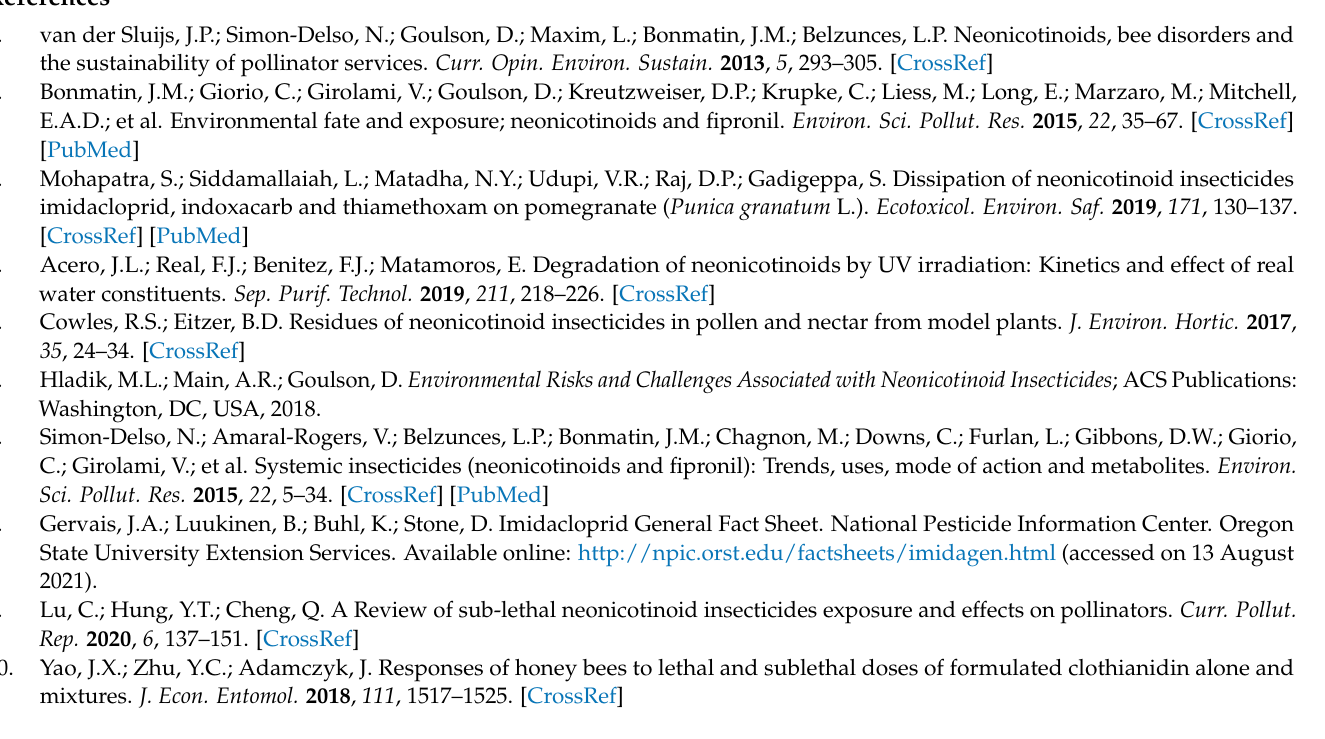
design for the second experiment; Figure S3: photographs of normal and abnormal monarch pupae and pupation; Figure S4: Response of bumble bees to neonicotinoid exposure; and Figure S5: Time to pupation for experiment